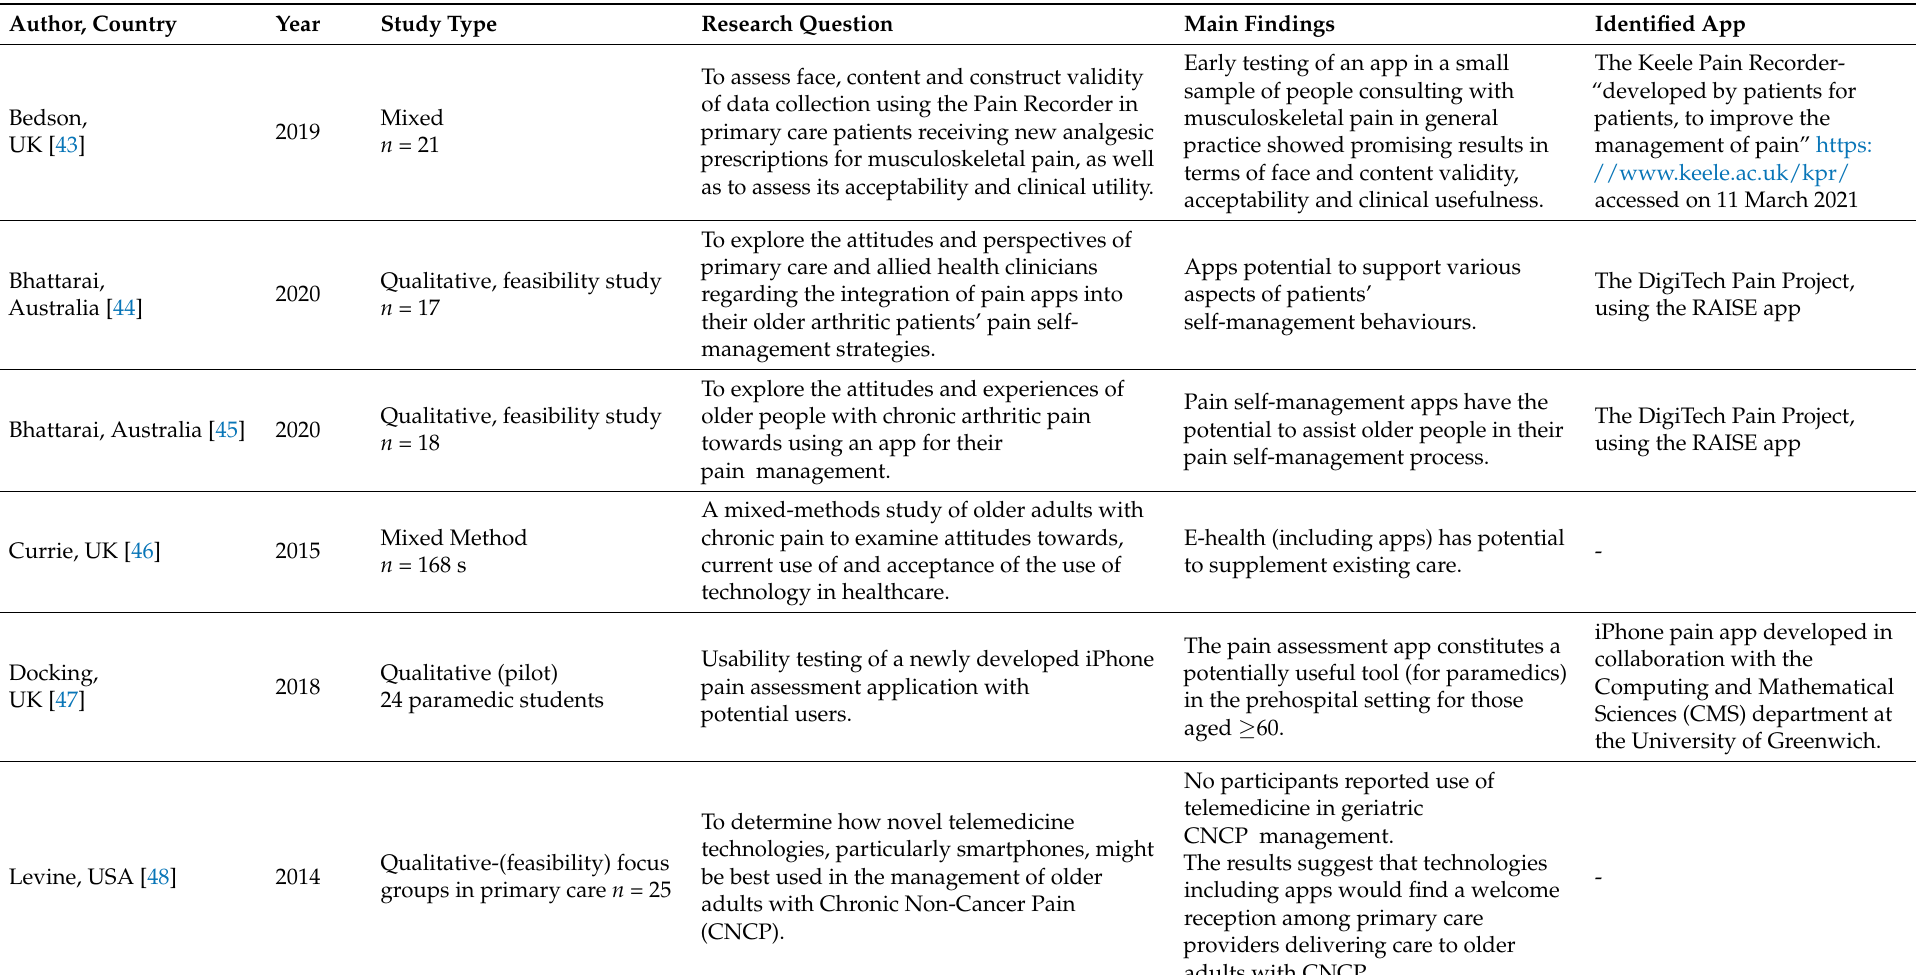
Table 2. Summary of selected